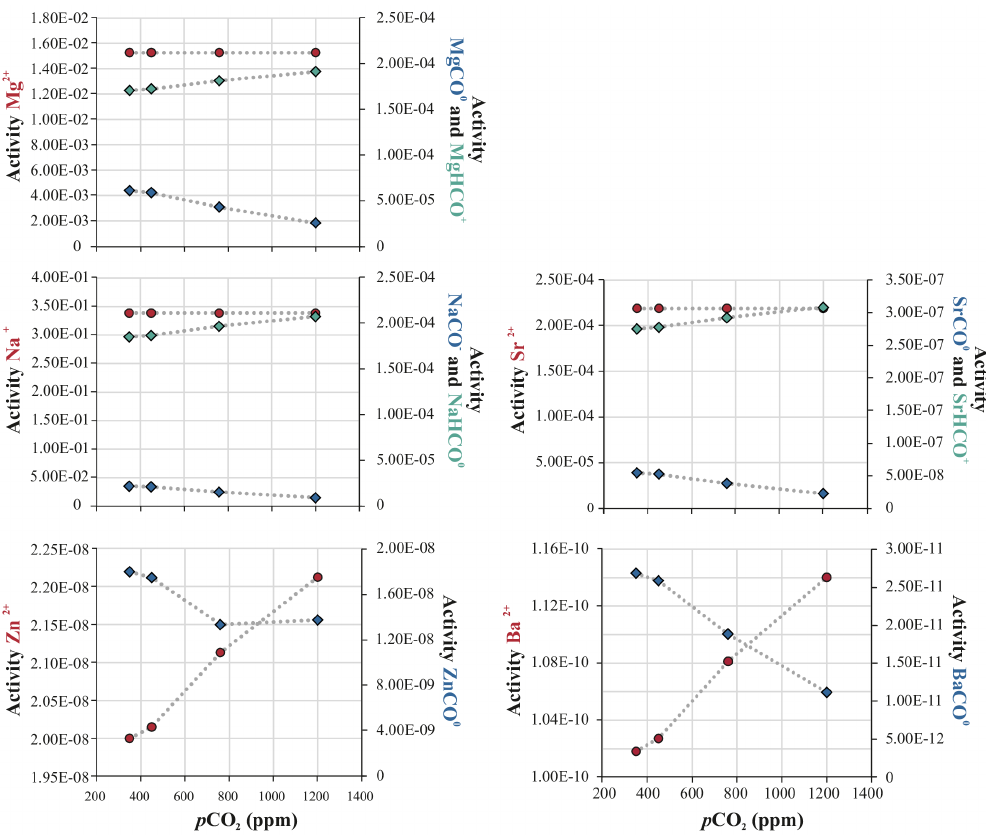
Figure 5. Speciation of Mg, Na, Sr, Zn and Ba in the different seawater treatments modeled in PHREEQC (Parkhurst and Appelo, 1999). Activities of free ions (red) and element ( E )–carbonate complexes (ECO 3 , blue diamonds; EHCO 3 , green